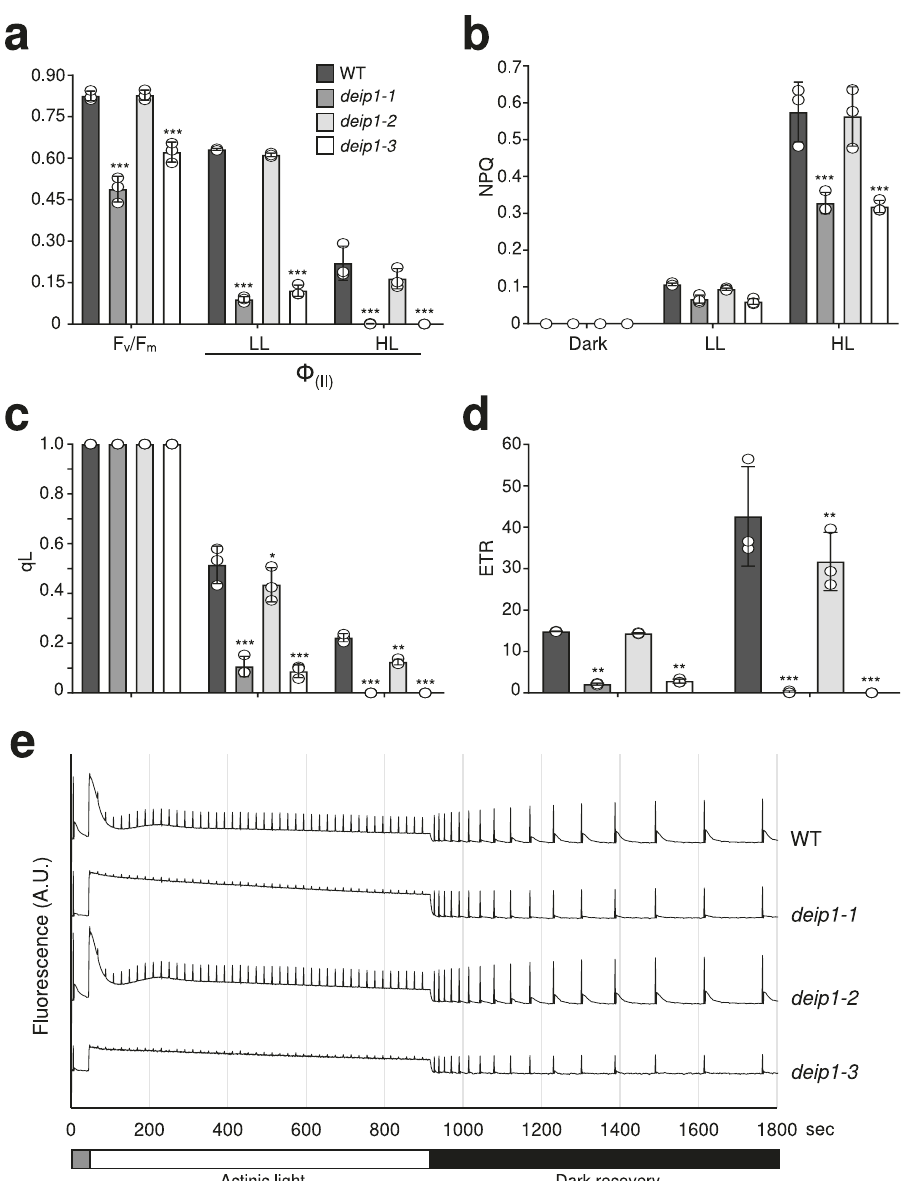
Fig. 2 Measurement of photosynthetic performance in the wild-type and the deip1-1 , deip1-2, and deip1-3 mutants. The chlorophyll fl uorescence parameters a maximum quantum yield (F v /F m ) and effective quantum yield ( Φ II ), b non-photochemical quenching (NQP), c open reaction centers of photosystem II (qL), and d electron transport rate (ETR) were obtained by PAM imaging of wild-type (WT), deip1-1 , deip1-2, and deip1-3 seedlings grown for 7 days. n = 3 independent biological replicates (with 15 seedlings each); error bars represent standard deviation; Statistical signi fi cance was determined by one-sided two-way ANOVA, P values were adjusted by Tukey post-test for multiple comparisons and comparing the deip1 mutants to the wild type at the same light intensity; * P < 0.05, ** P < 0.01, *** P < 0.001. LL: low light (56 PAR); HL: high light (461 PAR). e Chlorophyll a fl uorescence induction kinetics of wild-type plants (WT), deip1-1 , deip1-2, and deip1-3 . The intensity of the actinic light was 198 PAR. The curves are representative measurements